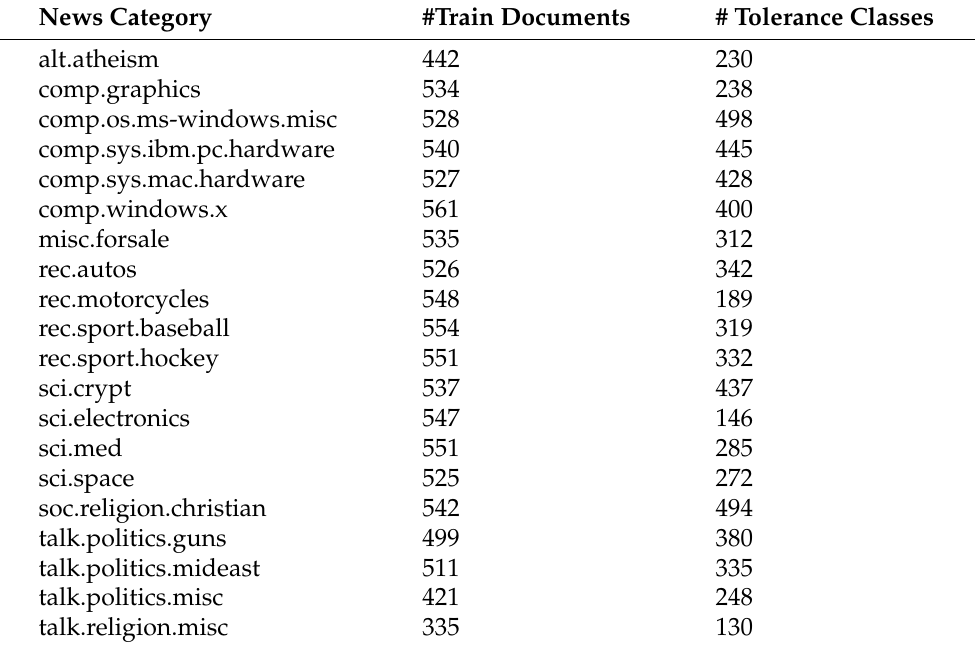
Table 2. 20-Newsgroups dataset for best ε value of